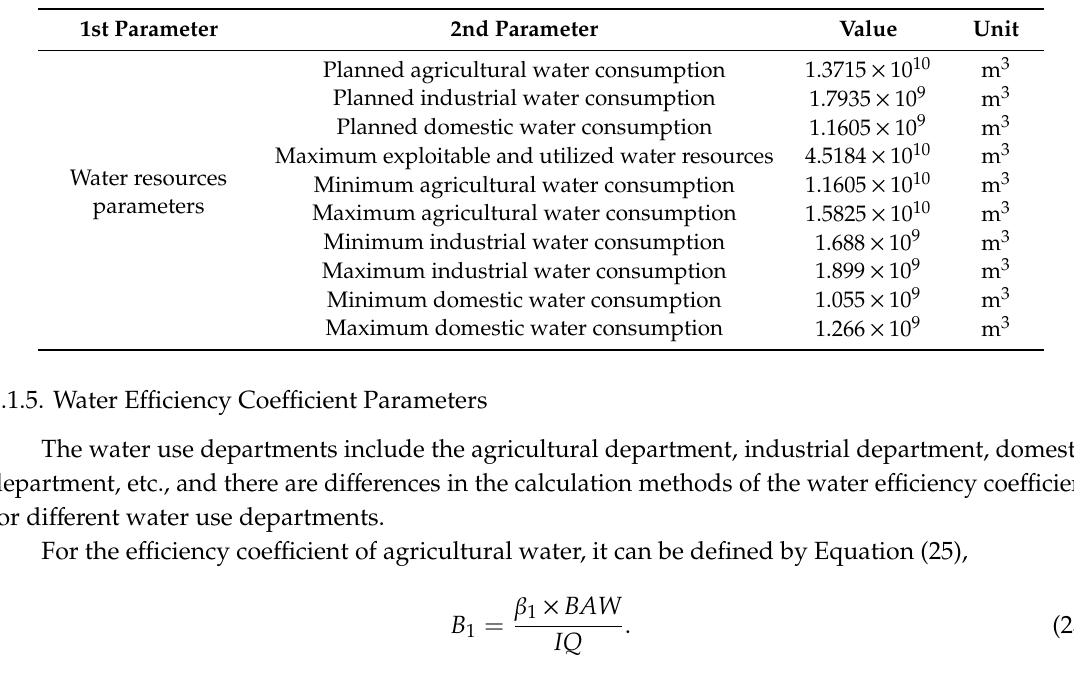
Table 4. Water resources parameters of a water–energy–food system in Inner